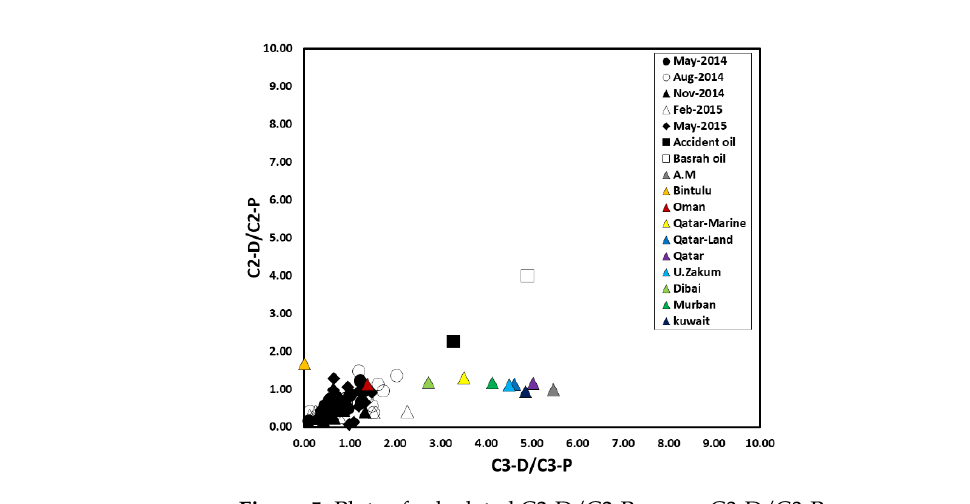
Figure 5. Plots of calculated C2-D/C2-P versus